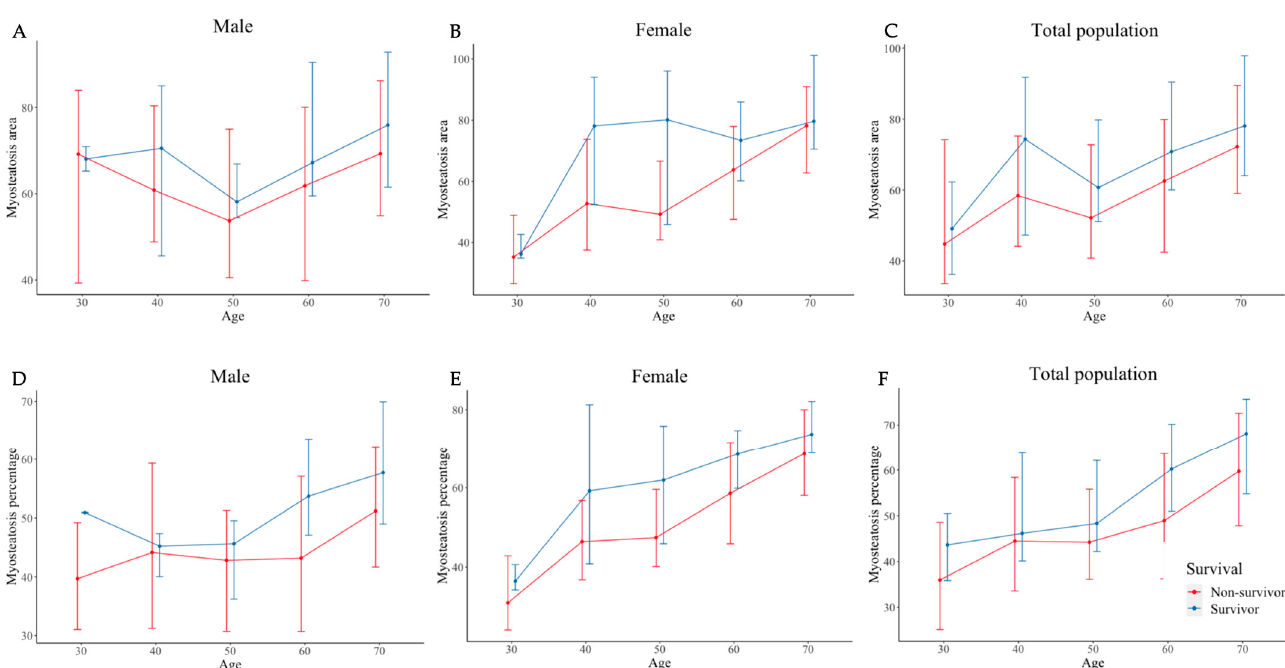
Figure 3. Distribution of myosteatosis area ( A – C ) and percentage ( D – F ) according to the age groups in male, female, and total patients.